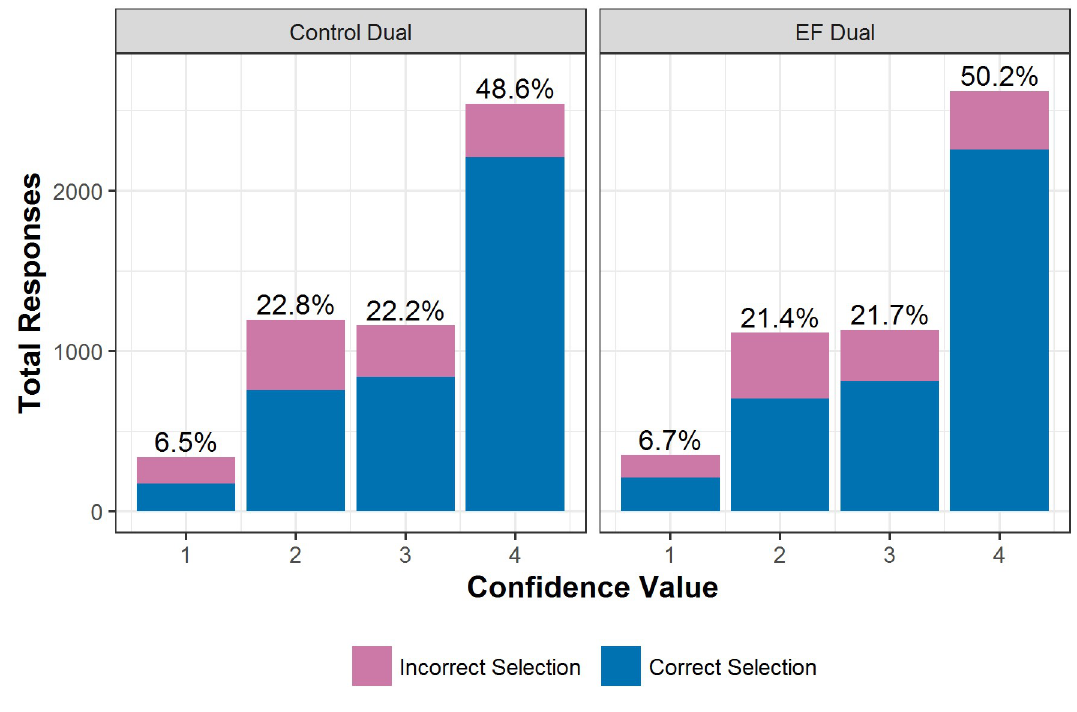
Fig 7. Total responses given at each level of the confidence scale, split by the accuracy of the visual discrimination. Percentages indicate the percentage of all responses in that block at that confidence level.